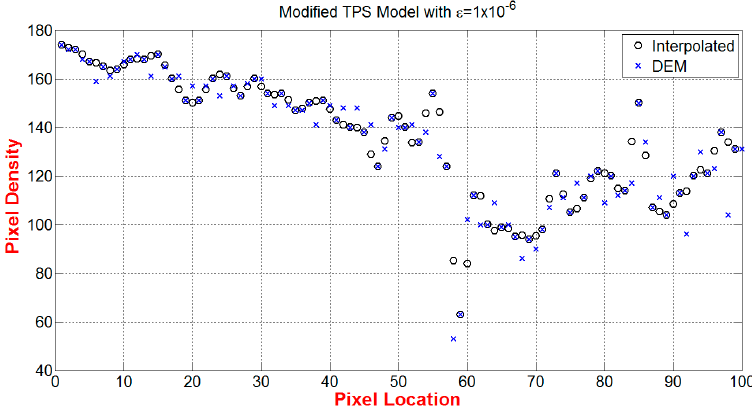
Figure 5. Comparison between the true values and the interpolated pixels which are evaluated between the intermediate points along column 37 of the image in Figure 4b. The true values are obtained from the DEM in column 74 of the image in Figure 4a.